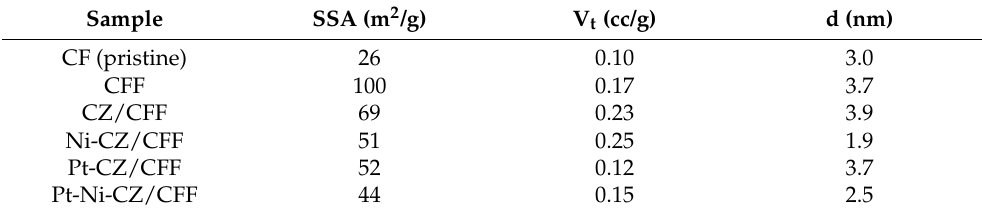
Table 2. Textural properties of CFF supported CeZrO 2 , Ni-CeZrO 2 , Pt-CeZrO 2 , Pt-Ni-CeZrO 2 cata- lysts.